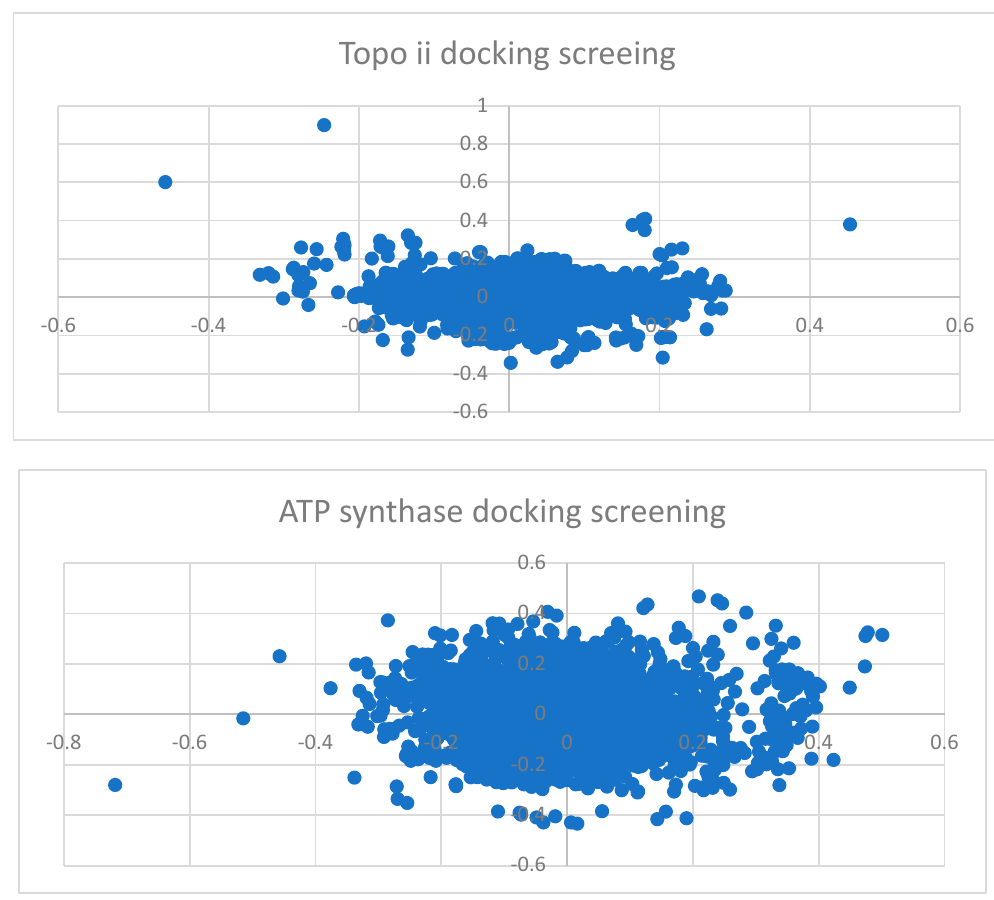
Figure 8. Docking results cluster for screening compounds docked with bacterial TOPO II and ATP synthase.